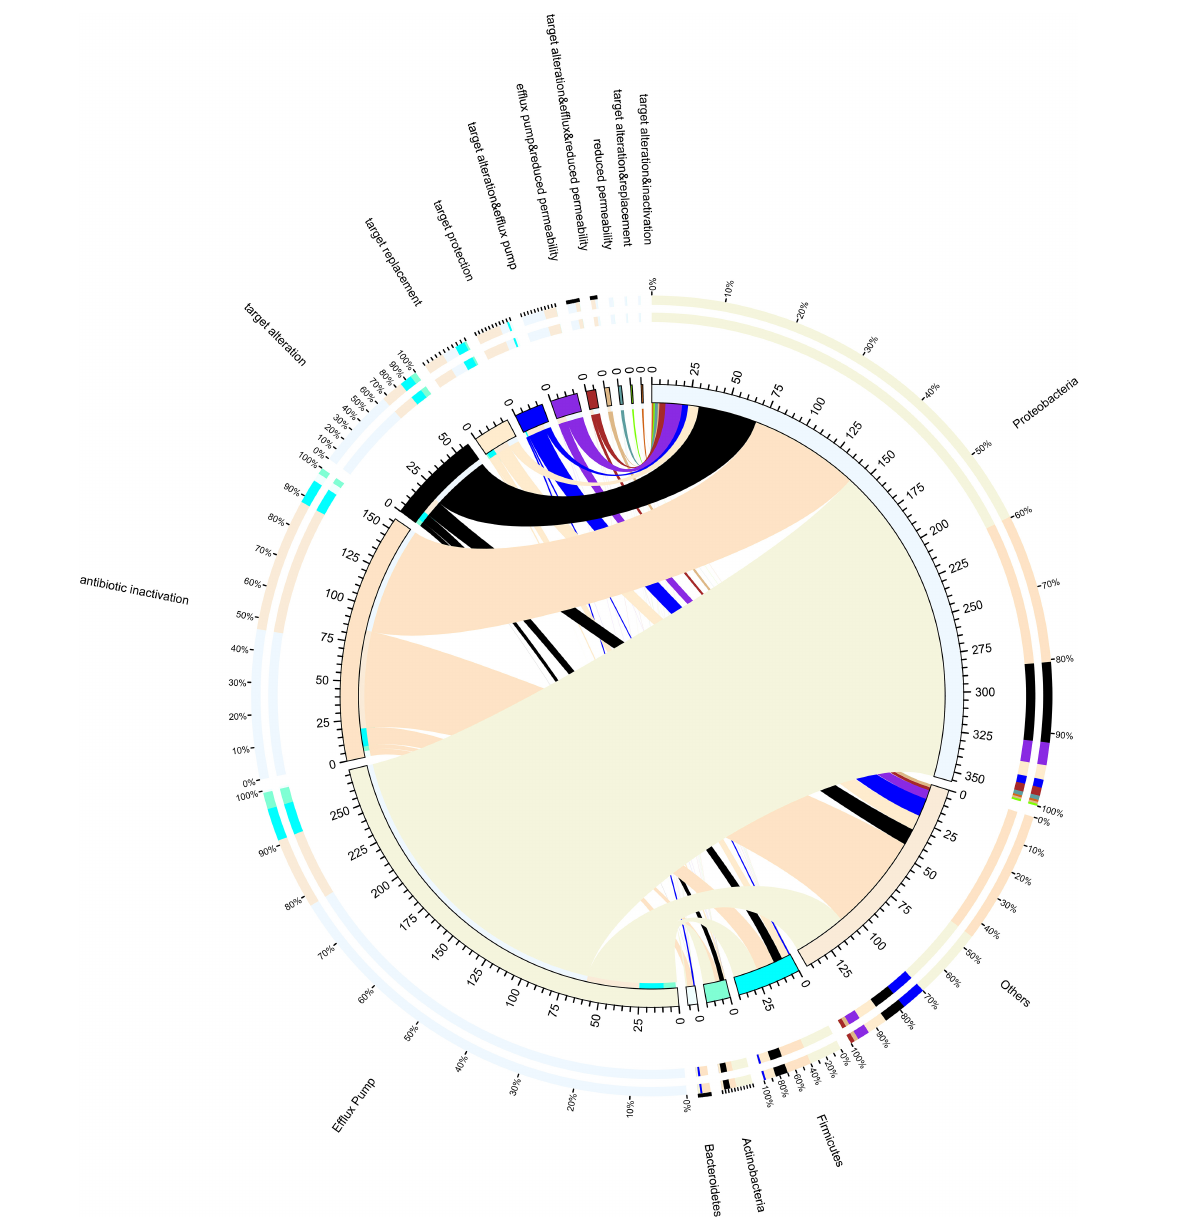
FIGURE3 Resistance mechanisms and species circle map. On the right is the phylum-level species information, and on the left is the resistance mechanism information. Different colors of the inner circle indicate different species and resistance mechanisms of resistance, and the scale is the number of